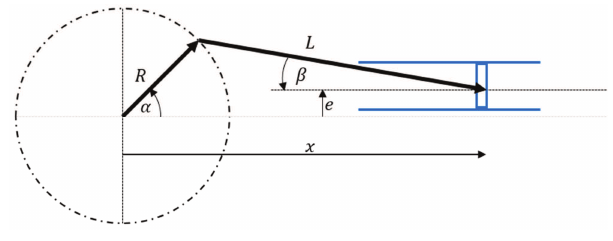
Fig. 1. STDE engine